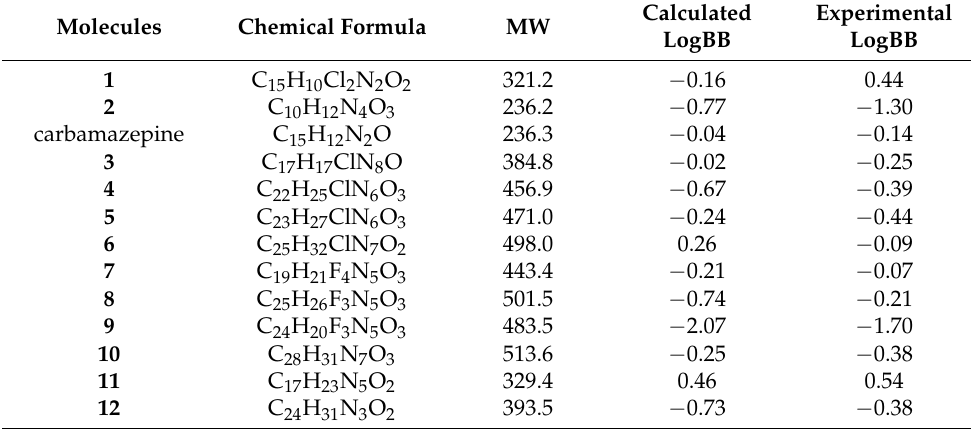
Table 3. Characteristics of the ten molecules used for the experimental validation of the AlphaQ prediction model for LogBB in comparison with those of 1 , 2 , and carbamazepine. Molecules Chemical